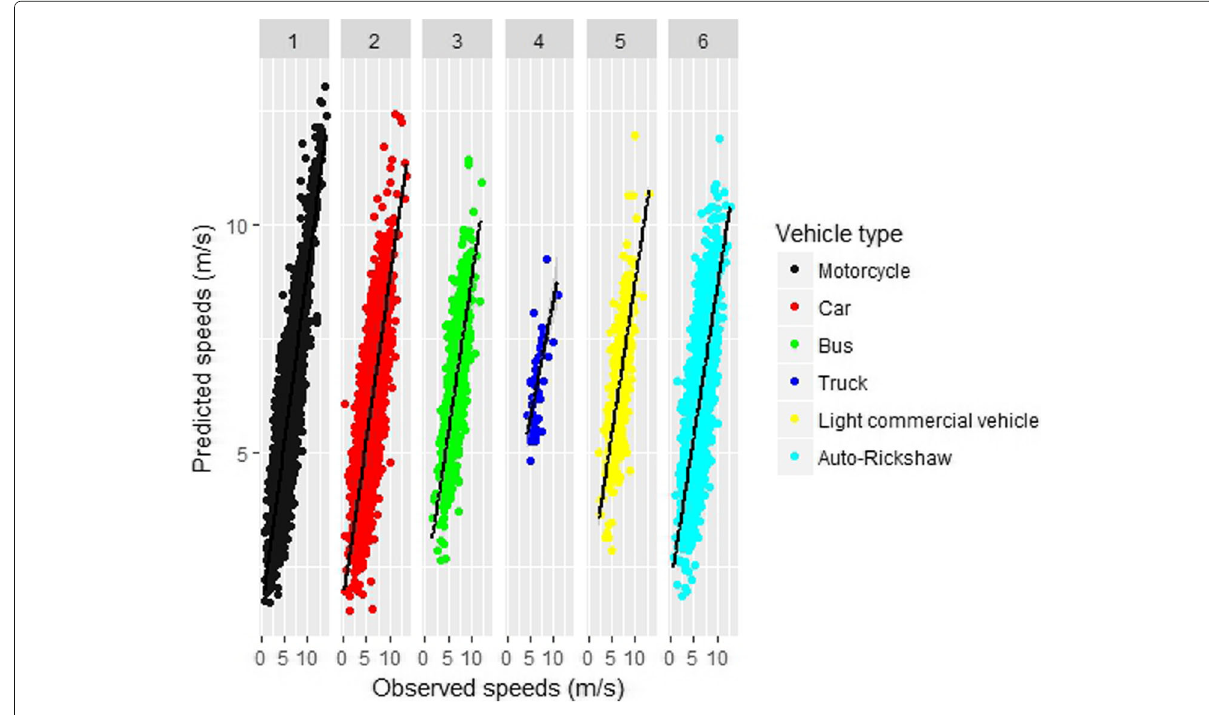
Fig. 9 Linearity assumption per vehicle type